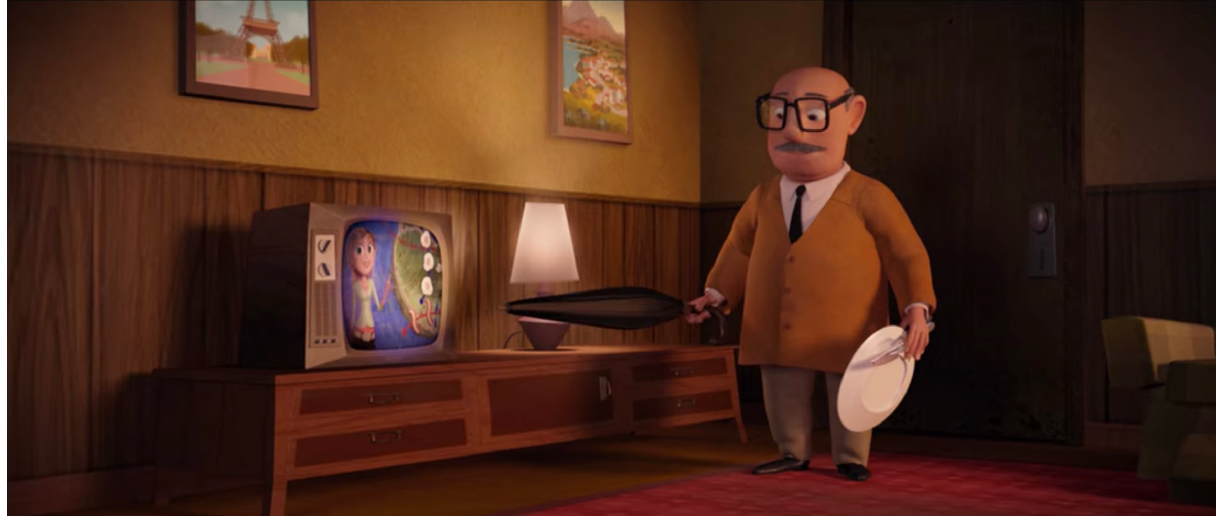
Figure 2: A Swallow Falls resident considers his options upon watching Sam Sparks’s food weather report ( Cloudy 1